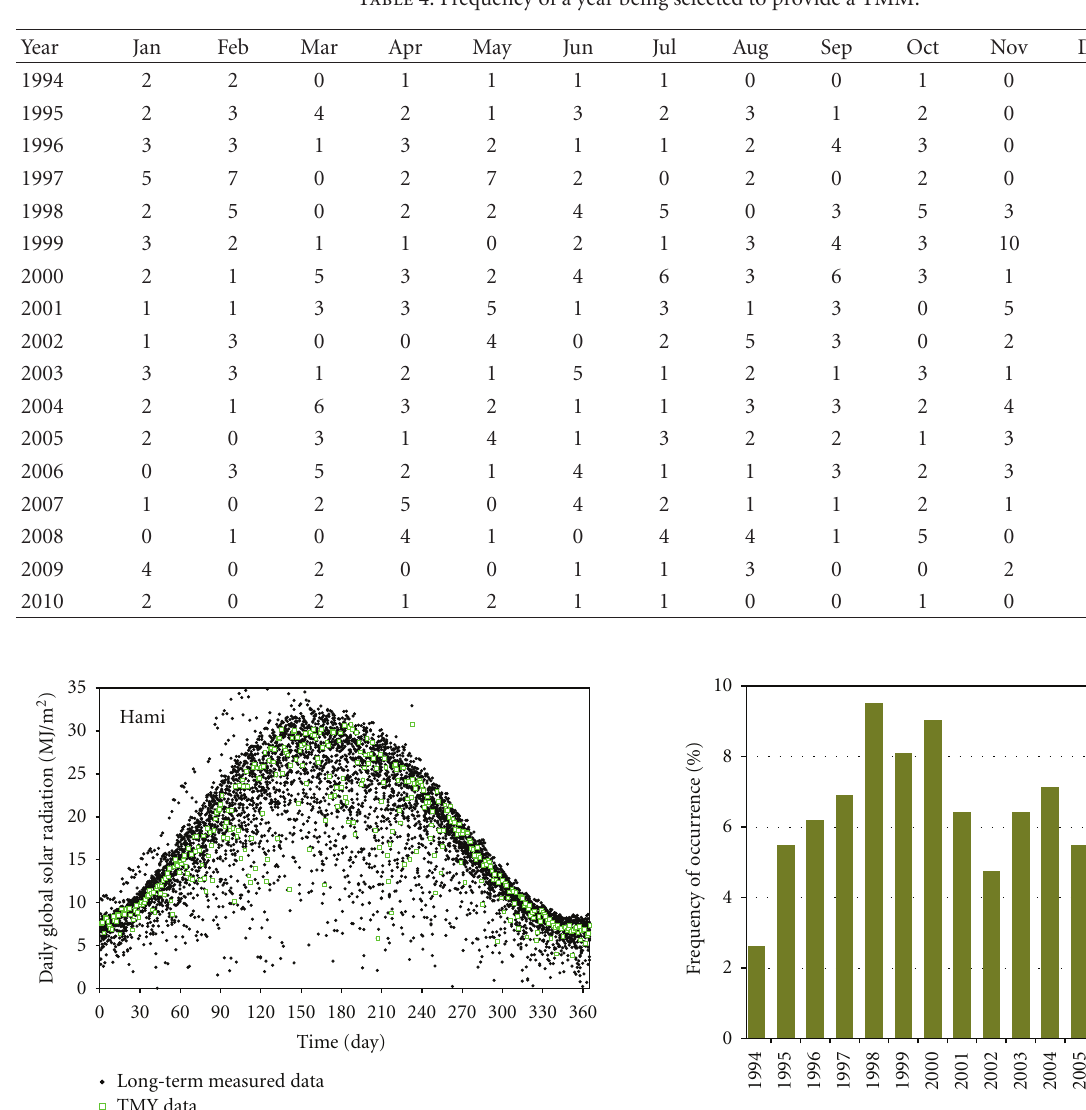
Table 4: Frequency of a year being selected to provide a TMM.